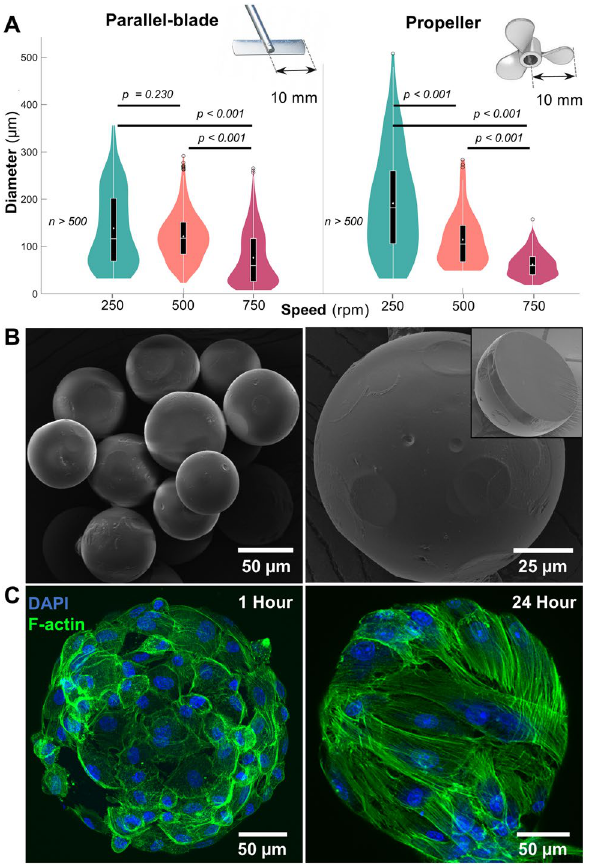
Figure 1. Microgel fabrication and characterization. ( A ) Size distribution of gelatin microgels made using straight-blade and propeller impellers at mixing speeds of 250, 500, and 750 rpm (n ≥ 500). Violin plot: White dots and lines represent mean and median, respectively. Black boxes, whiskers, and circles represent interquartile ranges, 25/75 quartile ranges, and outliers, respectively. ( B ) Scanning electron micrographs of dehydrated microgels with reduced size and a smooth outer surface. (Inset) Cross-section of a dehydrated microgel showing the core with a uniform, densely packed matrix. ( C ) Confocal micrographs of hydrated gelatin microgels seeded with mesenchymal stem cells showing a stretched cytoskeleton within 24